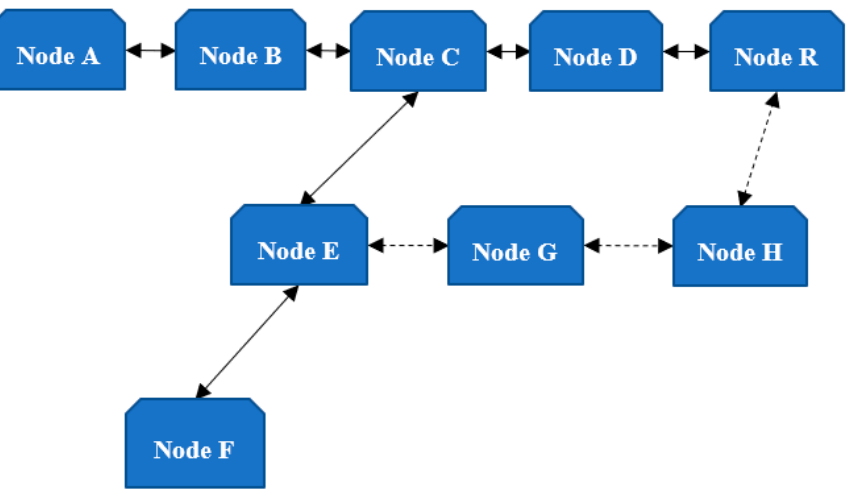
Figure 8. Multi-hop synchronization.